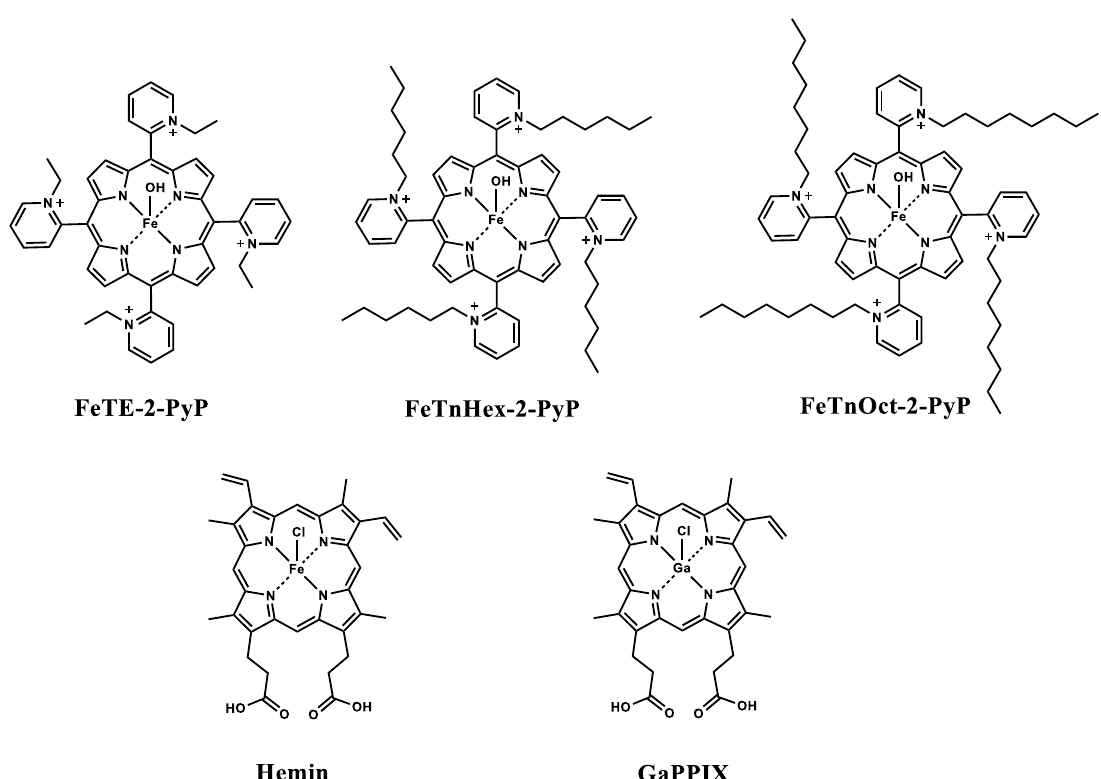
Figure 1. Structures of metalloporphyrins used in this study. In aqueous medium at pH 7.4, one axial water of Fe(III) ortho N -alkylpyridylporphyrins (FeTE-2-PyP, FeTnHex-2-PyP and FeTnOct-2-PyP) is deprotonated. Consequently, under such conditions cationic iron ortho N -alkylpyridyl porphyrins (FePs) bear one hydroxo (OH − ) ligand and one trans-axially bound water molecule (not shown here for clarity) [24,27]. Hemin and GaPPIX structures are presented in the solid form as they were received.